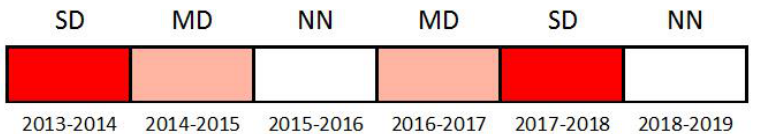
Figure 2. Graphical representation of the droughts’ classification of the hydrological years according to SPI [37] in the SDAF. SD = severely dry; MD = moderately dry; NN = near normal.